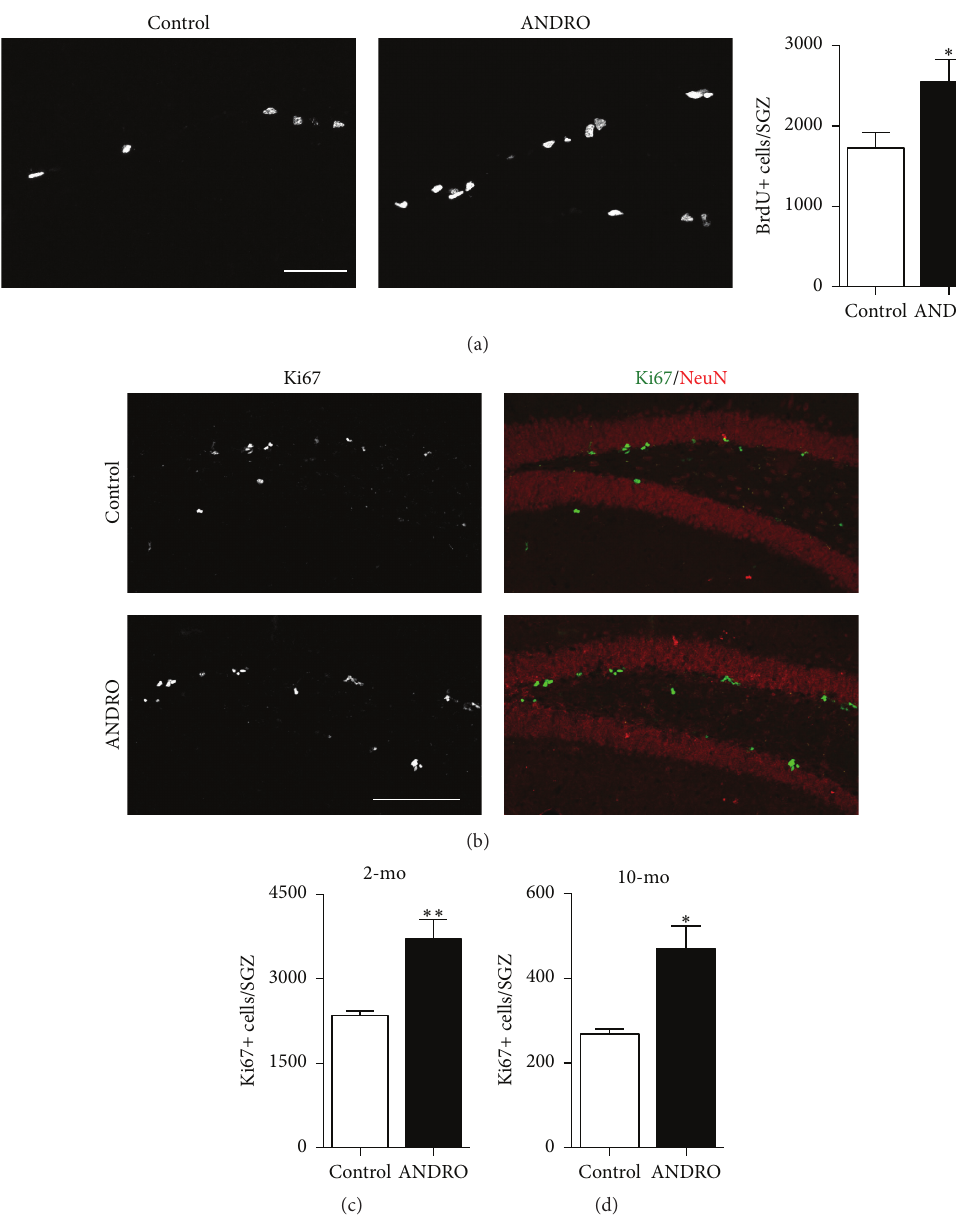
Figure 1: ANDRO induces proliferation in the dentate gyrus of adult mice. Two-month-old mice were injected i.p. with 2mg kg −1 ANDRO or vehicle as control 3 times a week for 4 weeks, received a single dose of 100mg kg −1 BrdU the last day of treatment, and were sacrificed 24 h after BrdU injection. (a) Images show representative immunostaining of BrdU. Scale bar: 50 𝜇 m. The graph shows total number of BrdU- positive (BrdU+) cells in the whole SGZ of control and ANDRO-treated mice. Bars represent mean ± S.E. ( 𝑛 = 7 mice). (b) Representative immunostaining of Ki67 and NeuN. Scale bar: 100 𝜇 m. (c, d) Total number of Ki67-positive (Ki67+) cells in the SGZ of control and ANDRO- treated 2-month-old (c) or 10-month-old (d) mice. Bars represent mean ± S.E. ( 𝑛 = 7 (c) and 𝑛 = 5 (d) mice). ∗ 𝑃 < 0.05 , ∗∗ 𝑃 < 0.01 , Student’s 𝑡